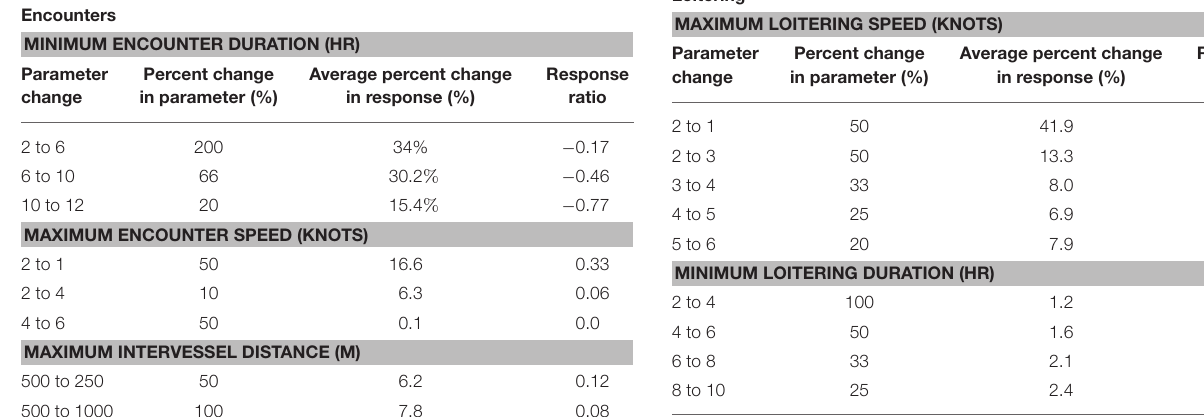
TABLE 2 | Sensitivity analysis of loitering events, identifying the sensitivity of total loitering hours to changes in two parameters (maximum loitering speed and minimum loitering duration) used to detect